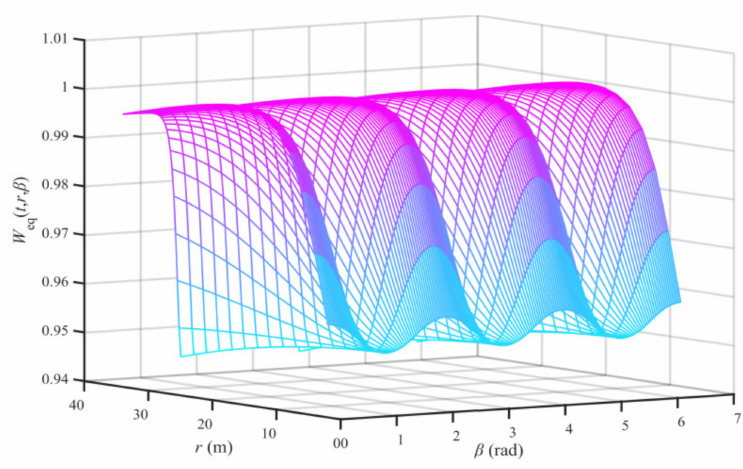
Figure 2. Equivalent wind speed transform coe ffi cient W eq .